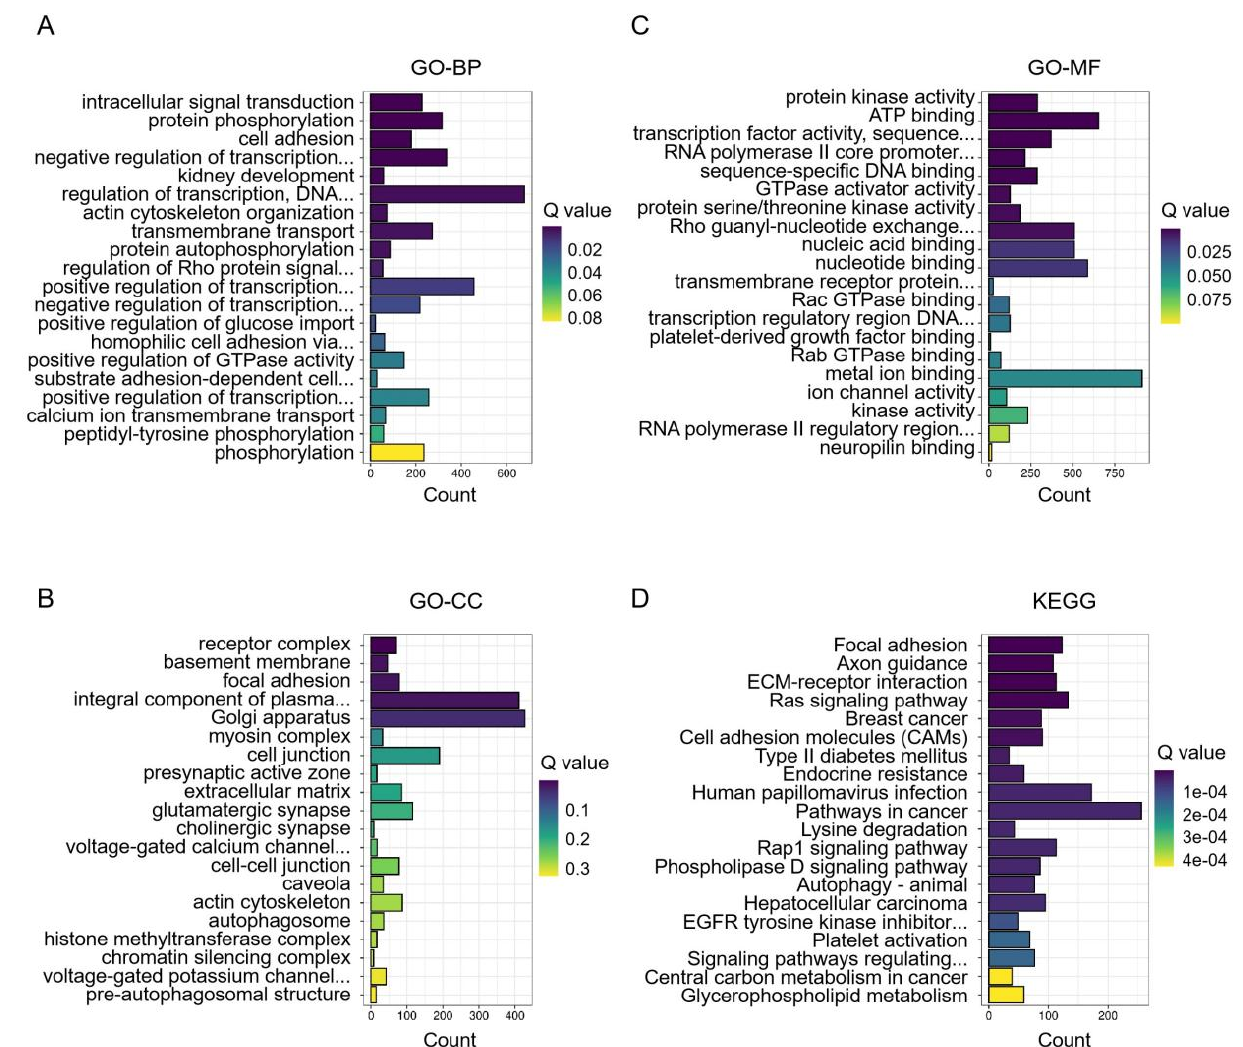
Figure 4. Enrichment analysis of differentially expressed miRNAs (DEMs) before and after transportation. ( A ) GO-BP analysis. ( B ) GO-MF analysis. ( C ) GO-CC analysis. ( D ) KEGG analysis.